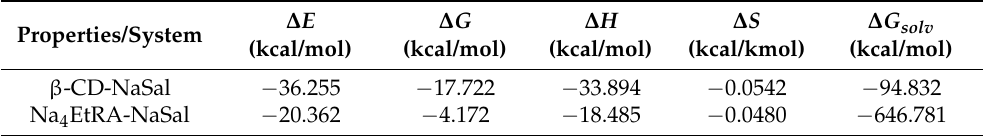
Figure 6. Structure of the different HG complexes obtained in the geometry optimizations. ( A ) β -CD-NaSal complex. ( B ) Na 4 EtRA-NaSal system. Table 4. Energy variation and thermodynamic properties of the complexation process.